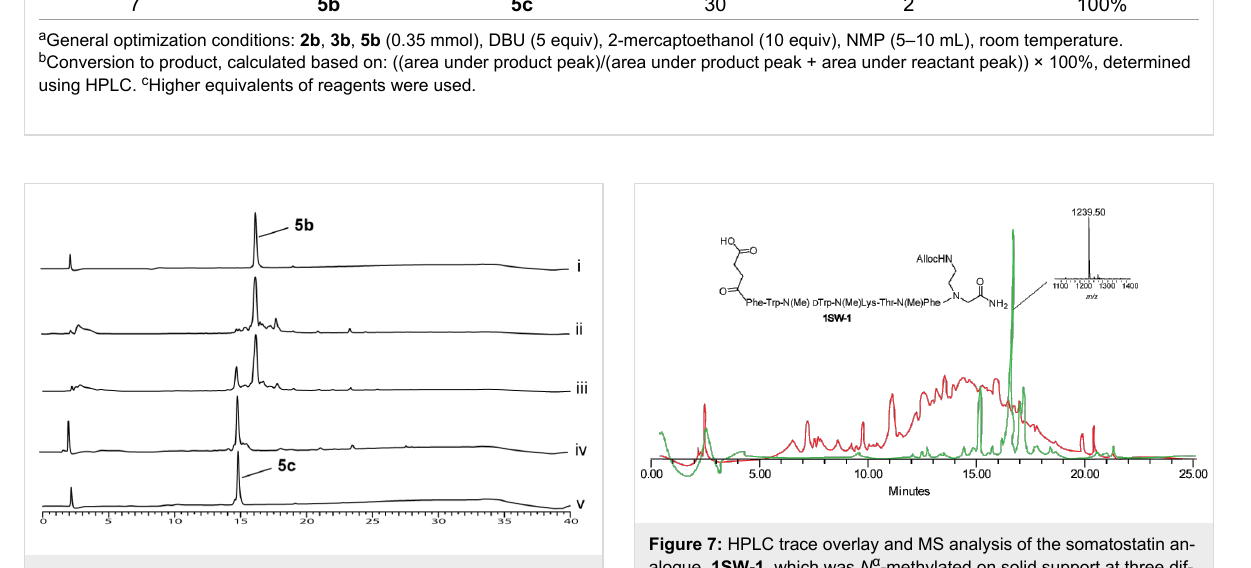
Figure 6: Optimization of o -NBS removal reaction conditions demon- strated on motif 5b . HPLC trace overlay of i) purified motif 5b . v) puri- fied motif 5c . ii) Crude reactant 5b . HPLC trace of crude mixture after removal of the o -NBS group using either, iii) two cycles of 5 minutes incubation or iv) two cycles of 30 minutes incubation.